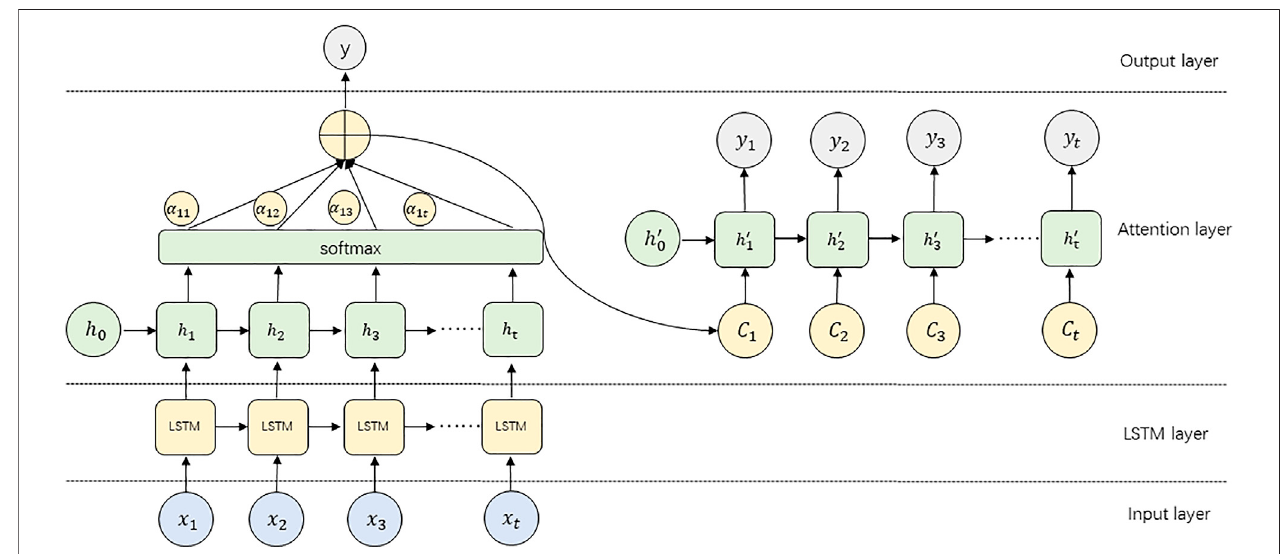
FIGURE 1 | The structure of the A-LSTM